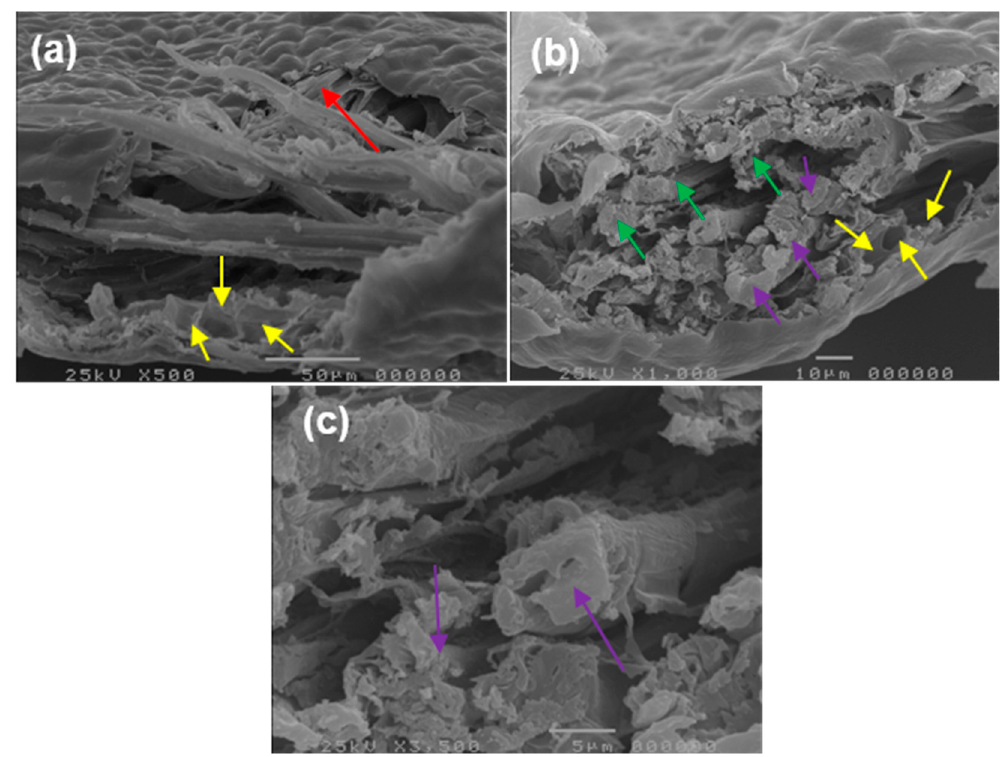
Figure 3. SEM images of cross-section cut of the leaf. ( a ) ×500, ( b ) ×1000, and ( c )